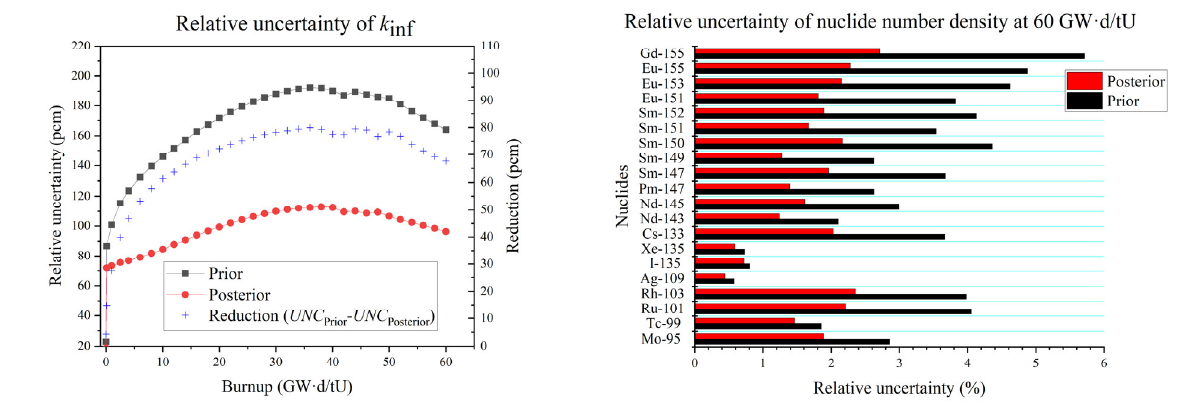
Fig.11. Comparison of prior and posterior uncertainties of the TMI-1